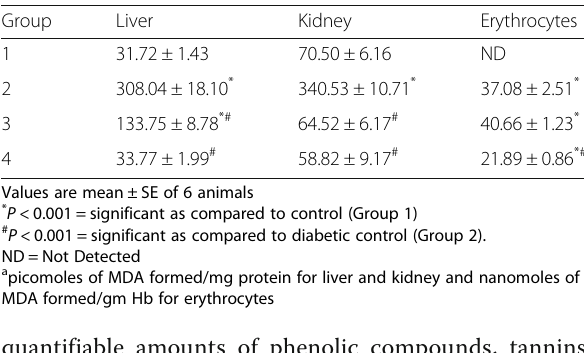
Table 5 Effect of HIE on liver, kidney and erythrocytes LPO in STZ induced diabetic mice LPO a Group